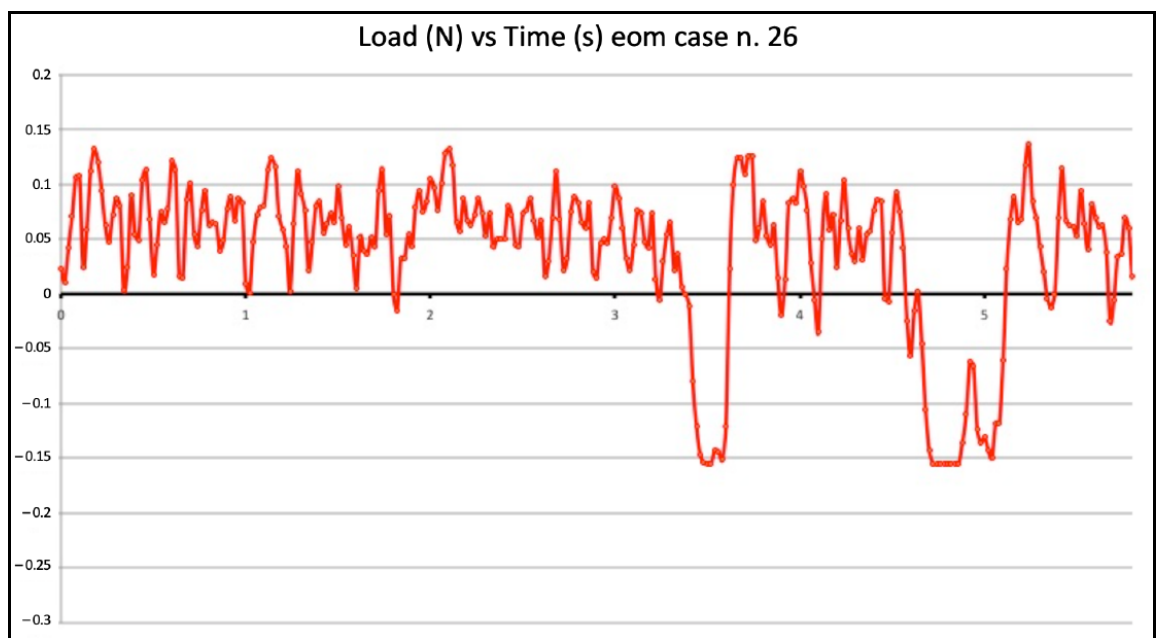
Figure 7. Graphic plot of the simulation on model n. 26 (successful envelope of motion negotiation).